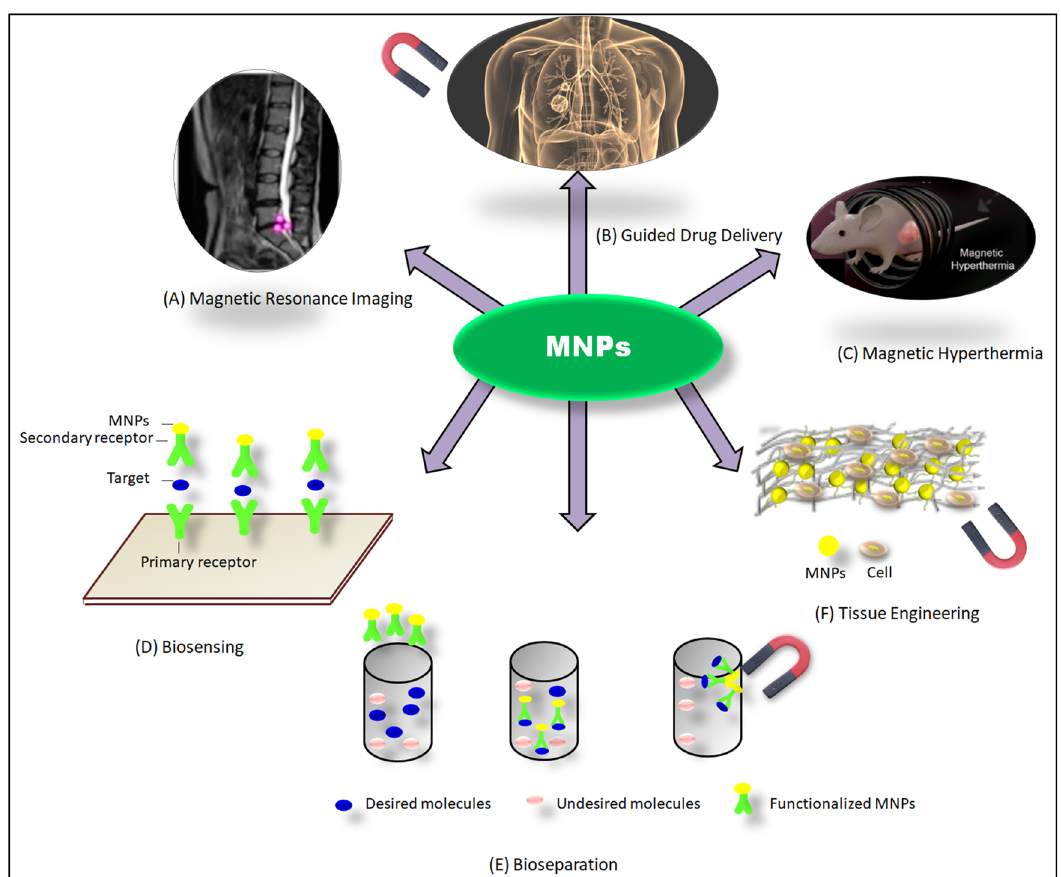
Figure 6: Schematic presentation of various applications of MNPs: ( a ) MRI, ( b ) drug delivery, ( c ) magnetic hyperthermia, ( d ) as biosensors, ( e ) bioseparation, and ( f ) tissue engineering in biomedicine. Reprinted from ref. [ 8 ] by Creative Commons